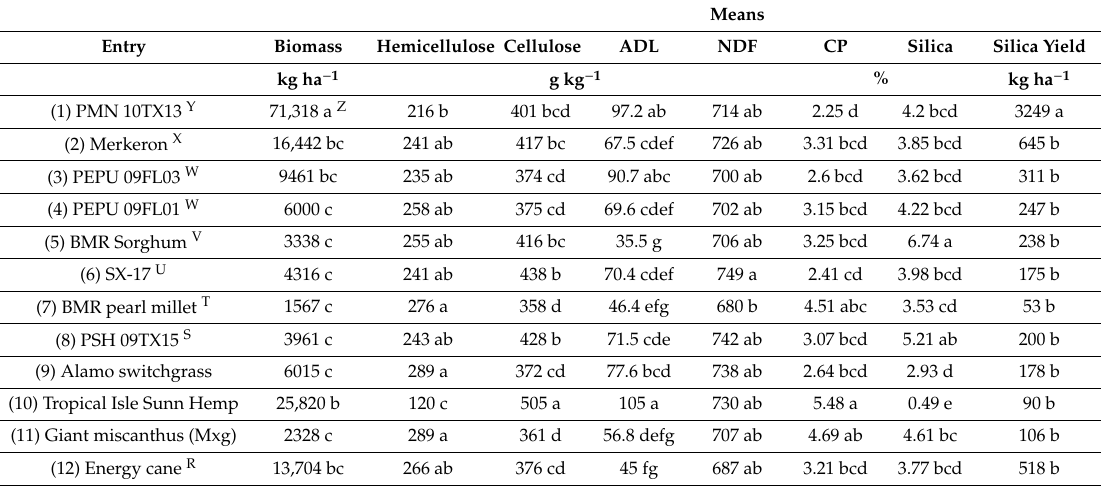
Table 4. First year College Station sample traits of biomass yield (kg ha − 1 ) and chemical composition including hemicellulose, cellulose, acid detergent lignin (ADL), neutral detergent fiber (NDF) (g kg − 1 biomass), crude protein (CP) (%), silica (%), and silica yield (kg ha − 1